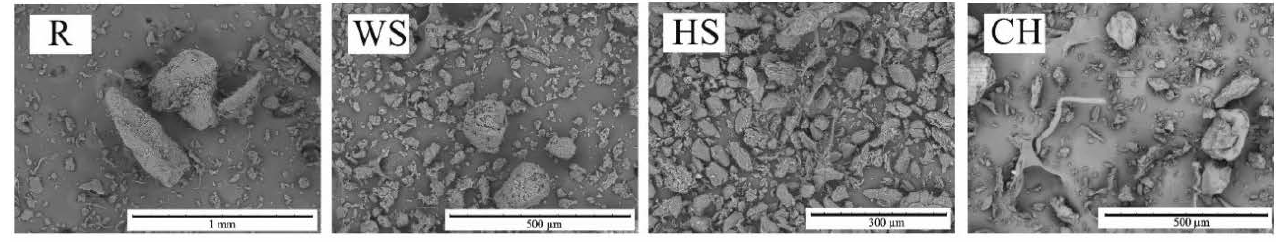
Figure 3. SEM images of the natural